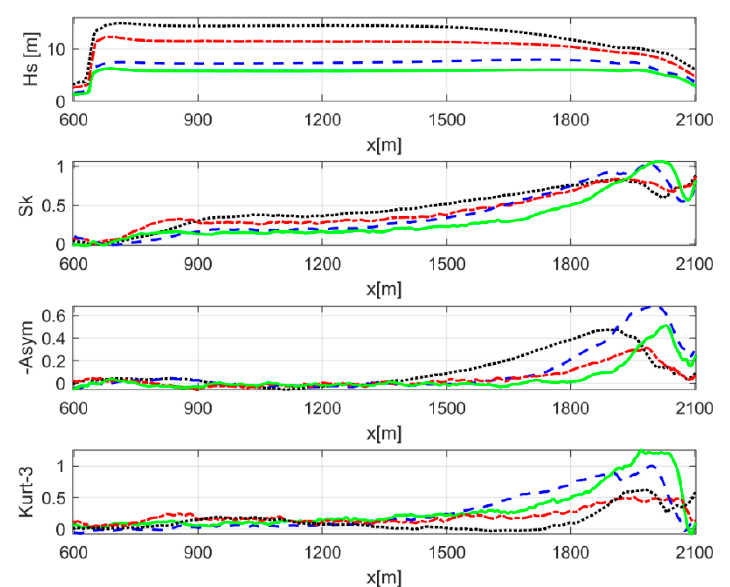
Figure 4. Evolution of the main statistical quantities over the slope shown for H6T12 (green solid), H7.5T16 (blue dash), H12T12 (red dash-dotted), and H15T16 (black dotted). Observe the substantial changes of Sk, As and the excess Kurtosis entering the shallower area D < 25 m (x > 1660 m).